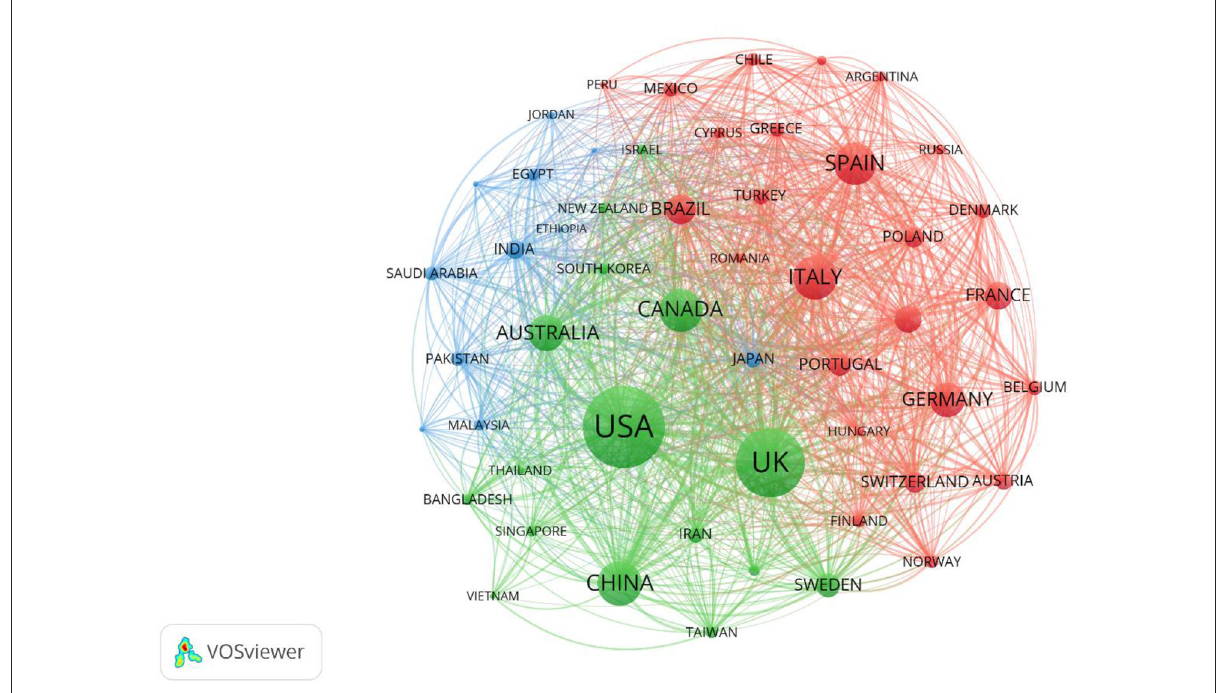
FIGURE5 Map of countries network. The nodes represent countries. The lines represent cooperation